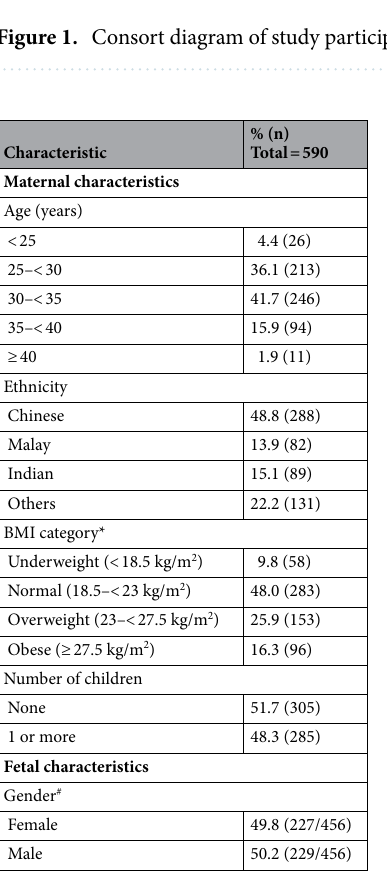
Table 1. Maternal and fetal characteristics of the study participants. BMI Body Mass Index. *BMI taken at presentation, stratified according to Asian-specific World Health Organization definitions. # Missing data for fetal gender at delivery, n =